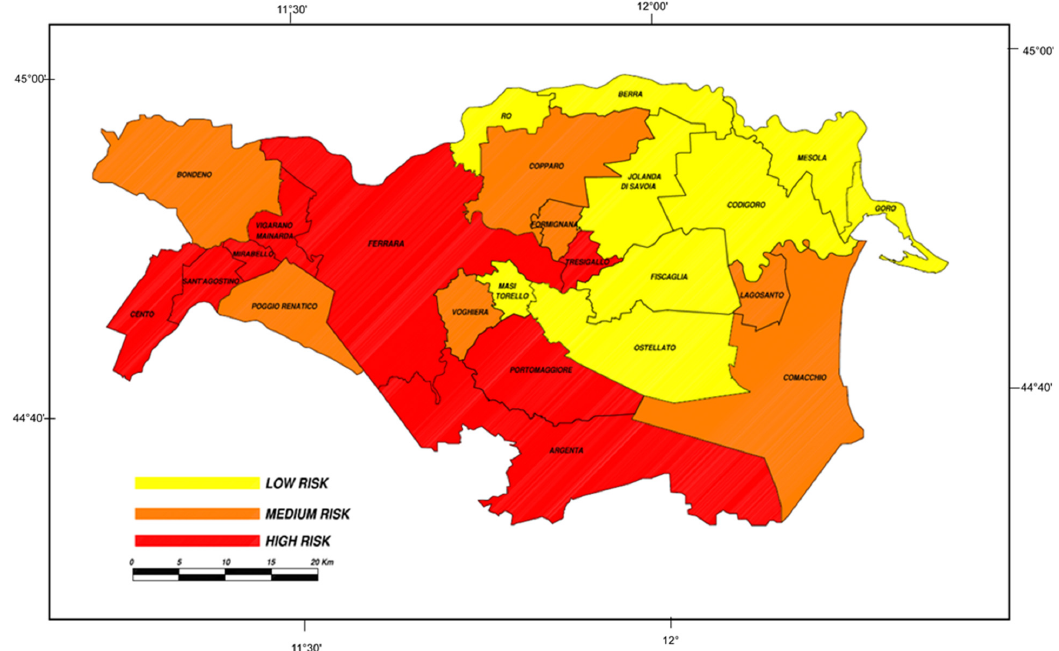
Figure 10. Multiple-risk map for the Ferrara province obtained for the usual preference function (Type 1 in Table 1). The risk levels strictly indicate the relative priority ranking for decision-makers and do not indicate the effective safety level of the various